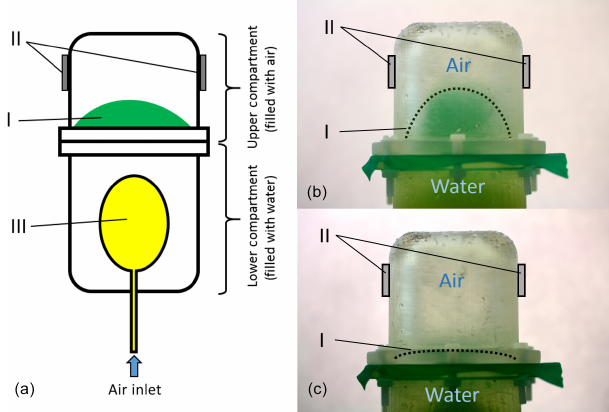
Figure 1. A technical drawing of the used lung phantom is shown in panel (a) . The lung phantom consists of two compartments. The lower compartment is filled with water and contains a balloon (III). By inflating the balloon, the water is pushed in the upper compart- ment and an elastic diaphragm (I) between the two compartments dilates. This case is shown in panel (b) . This models an exhaled state of the lung. By deflating the balloon, the diaphragm contracts. This models an inhaled state and is shown in panel (c) . The grey blocks (II) indicate the position at which the antennae were